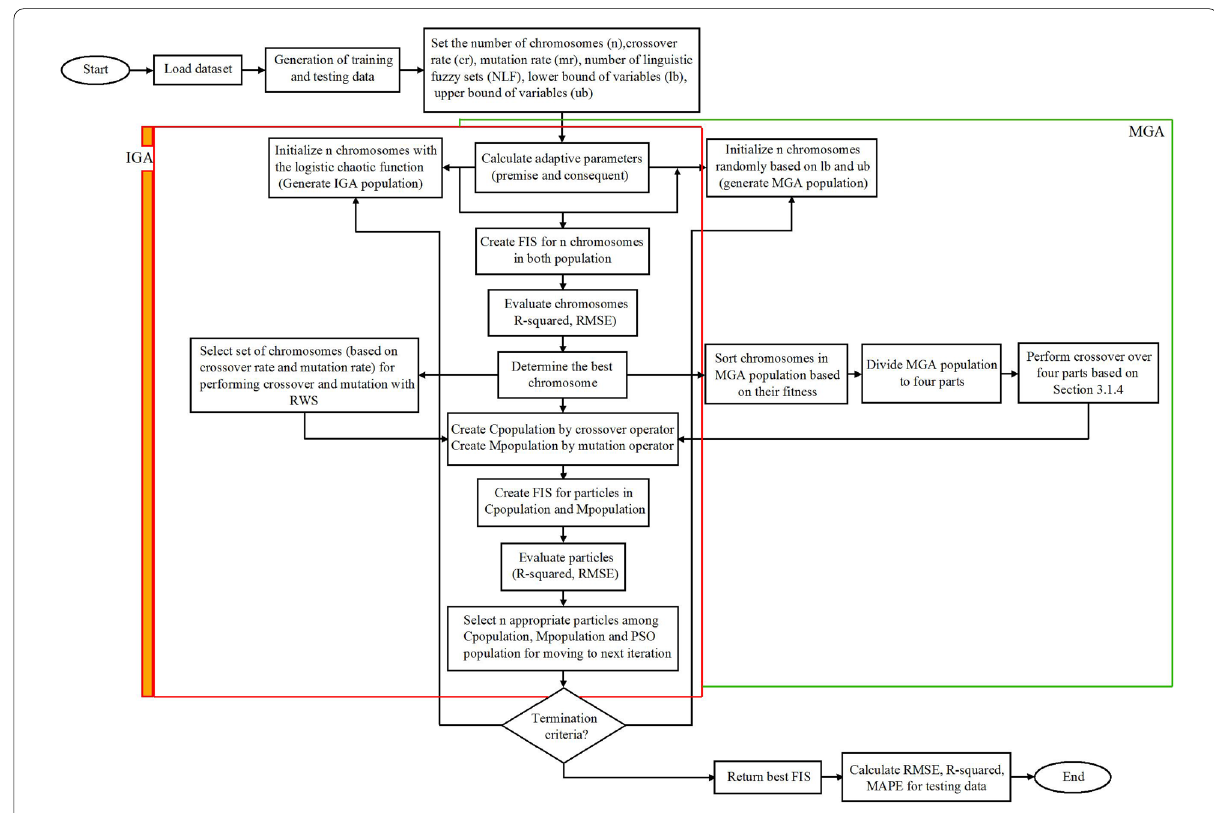
Fig. 6 GA-based ANFIS.